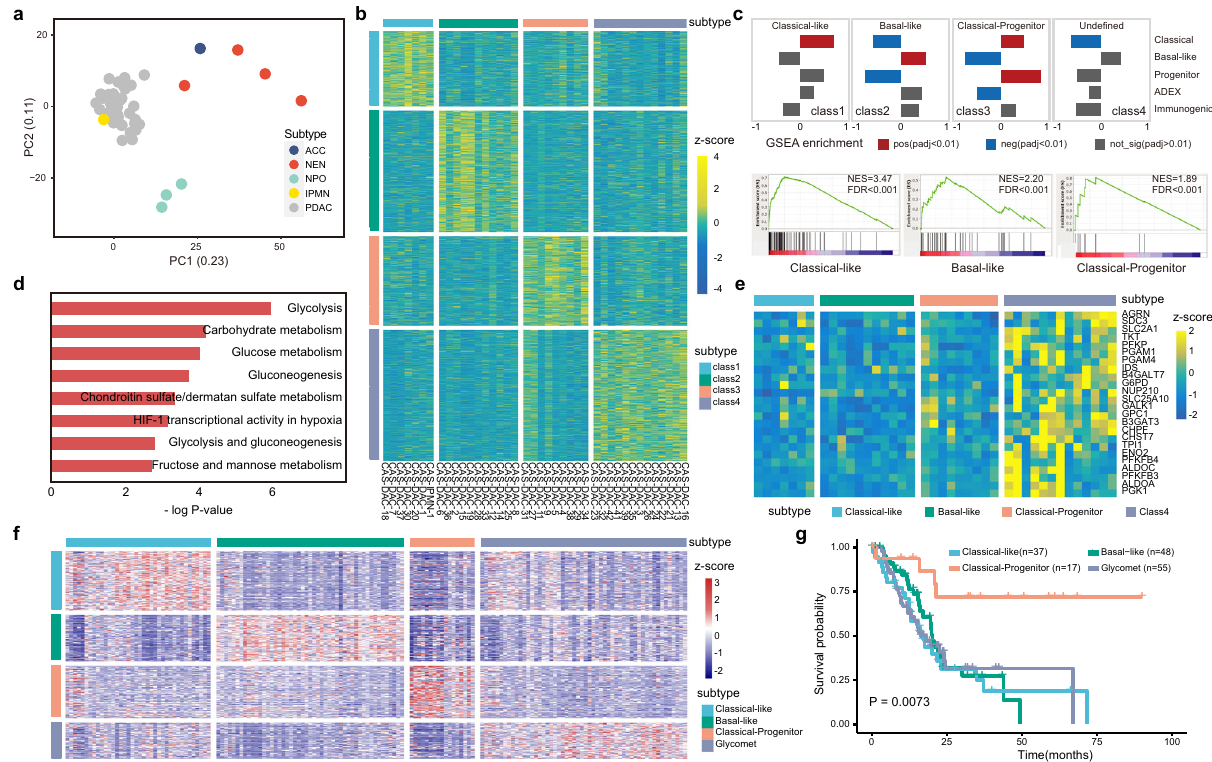
Fig. 3 Transcriptome analysis of PDPCOs. a PCA of gene expression for 45 PDPCOs in the discovery cohort: 39 CAS-DACs, 4 CAS-NENs, 1 CAS-IPMN and 1 CAS-ACC. b Heatmap of the four transcriptomic subtypes in the discovery cohort of 40 exocrine PDPCOs (39 CAS-DACs and 1 CAS-IPMN), as revealed by unsupervised NMF clustering. Samples are listed in columns, and signature genes are listed in rows as z-scores. c Identi fi cation of biological characteristics in each subtype by previously reported signatures. A P -value < 0.01 was used to determine positive or negative enrichment of published signatures in a subtype (top). Detailed GSEA results are shown at the bottom. d Bar graph showing the results of enrichment analysis of class 4 DEGs by Enrichr. Signi fi cance was computed by one-sided hypergeometric test. e Heatmap indicating the expression of glycolysis pathway-related genes across the four subtypes. Samples are listed in rows, and signature genes are listed in columns as z-scores. f External validation of the transcriptomic subtypes in the TCGA PAAD cohort. Samples are listed in rows, and signature genes are listed in columns as z-scores. g Kaplan-Meier survival analysis showing the overall survival characteristics of patients with the four transcriptomic subtypes, as identi fi ed in f . P value is determined by using log-rank test. PDPCO, patient- derived pancreatic cancer organoid; PDAC, pancreatic ductal adenocarcinoma; NEN, pancreatic neuroendocrine neoplasm; IPMN, intraductal papillary mucinous neoplasm; ACC, acinar cell carcinoma; NPO, normal pancreatic ductal organoid; PCA, principal component analysis; NMF, nonnegative matrix factorization; GSEA, gene set enrichment analysis; DEG, differentially expressed